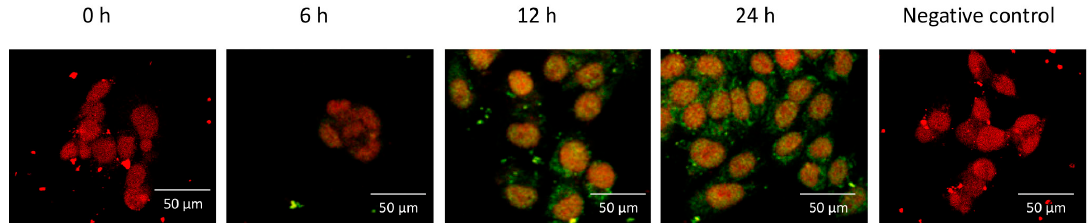
Figure 4. Representative photomicrographs showing the intracellular distribution of F-spondin protein (green) in the Ishikawa cells visualized by confocal microscopy. Nuclei were stained with propidium iodide (red). Note that F-spondin was mainly localized in the plasma membrane and cytoplasm after 2ME treatment. This experiment consisted of 5 replicates. Negative controls for immunoreactivity were incubated with preimmune serum.